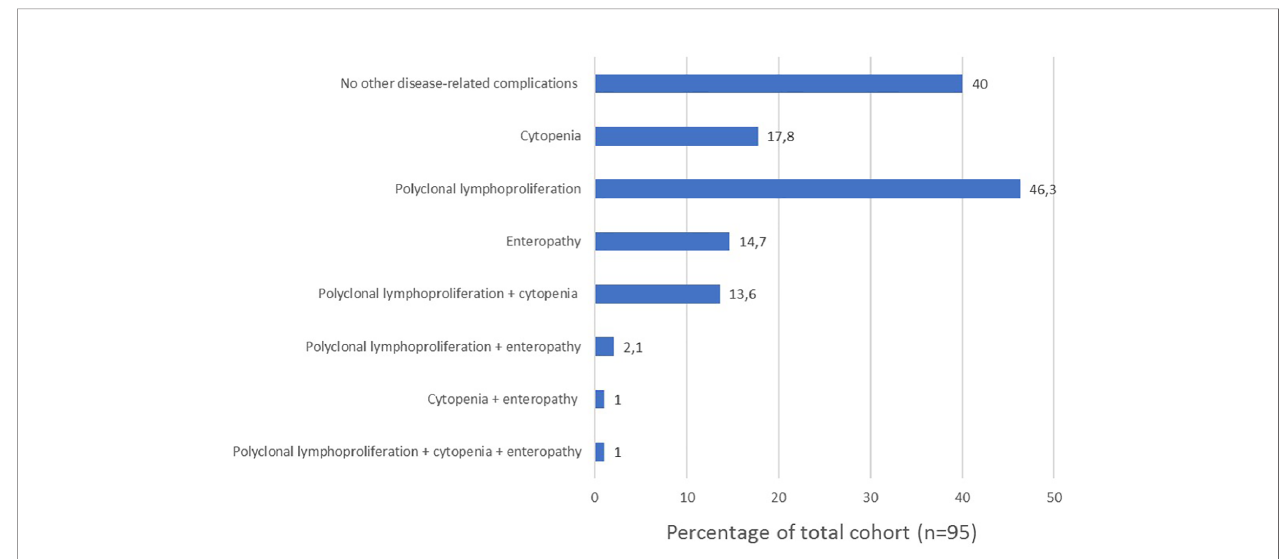
FIGURE 5 | Frequency of clinical phenotypes and their overlap in our cohort